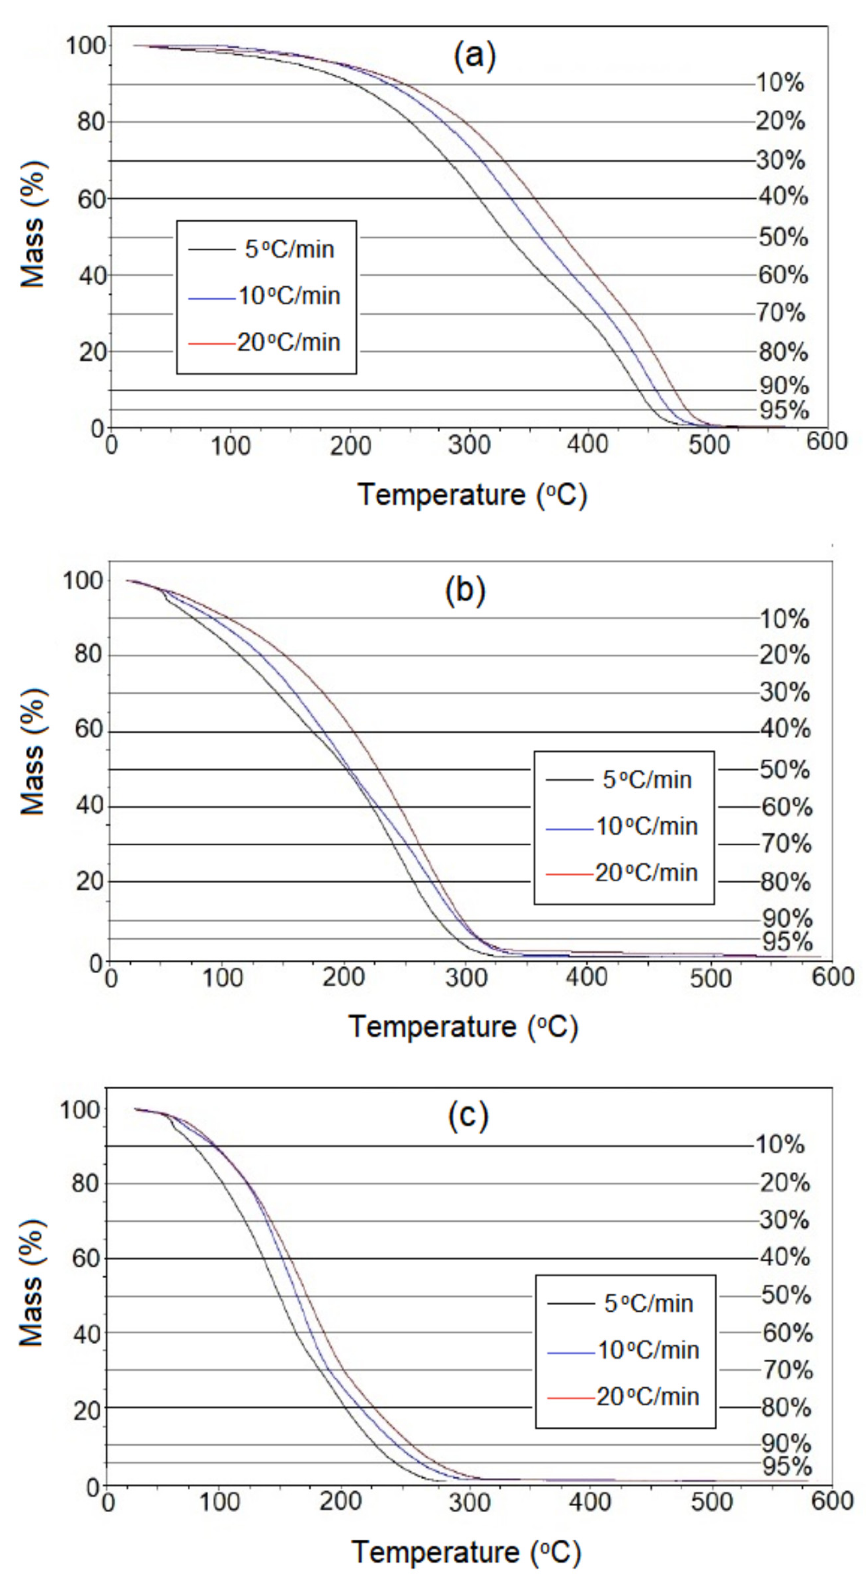
Figure 8. TG curves for thermal degradation ATR ( a ); catalytic distillation of HY/ATR ( b ); and HY-MCM-41 ( c ) samples at different heating rates, along with the degree of conversions.